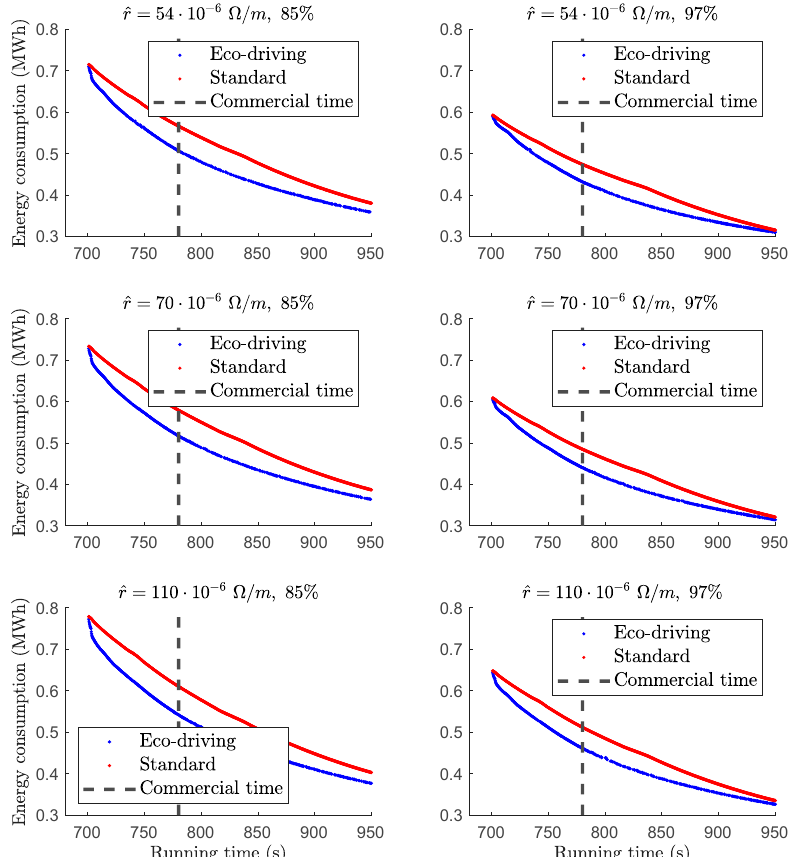
Figure 11. Pareto fronts for the net consumption at the electrical substations for the extreme values of the engine traction and braking efficiency (85% and 97%) and the three considered values of the linear resistance of the catenary ( 54 · 10 (cid:2879)(cid:2874) Ω/𝑚 , 70 · 10 (cid:2879)(cid:2874) Ω/𝑚 and 110 · 10 (cid:2879)(cid:2874) Ω/𝑚 ).